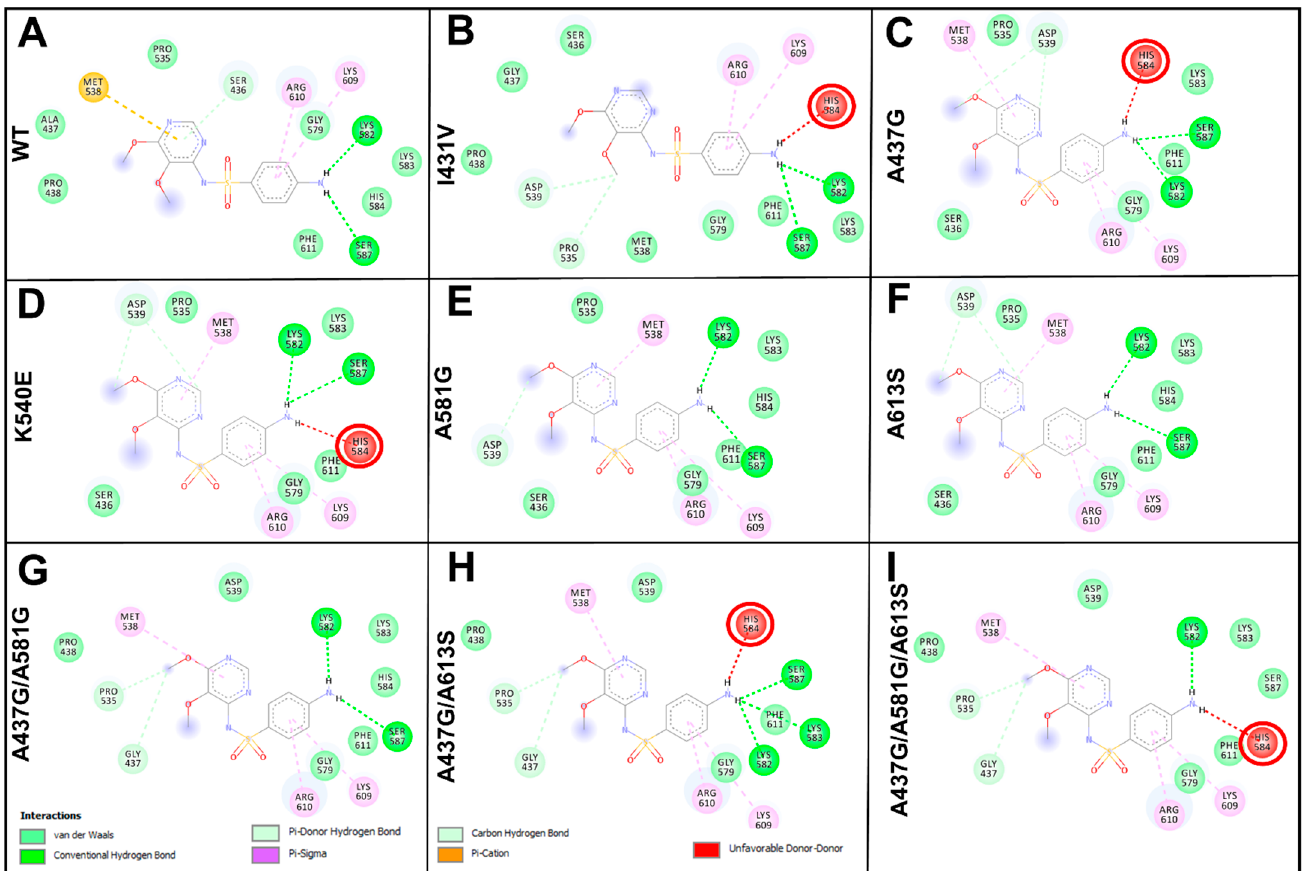
Figure 3. Molecular interaction fingerprint of SDX at the binding site of Pf dhps WT and the mutant proteins. Interaction fingerprints were generated using the DS visualizer. Hydrogen interactions are indicated in green. Unfavorable bonds are shown in red. ( A ) SDX interaction with the WT protein. (Panels ( B – F )) SDX interacting with the single mutants I431V, A437G, K540E, A581G, and A613S, respectively. (Panels ( G – I )) Interactions with the double mutants A437G/A581G and A437G/A613S and the triple mutant A437G/A581G/A613S, respectively. The pose/mode 4 in each docking cluster is shown.